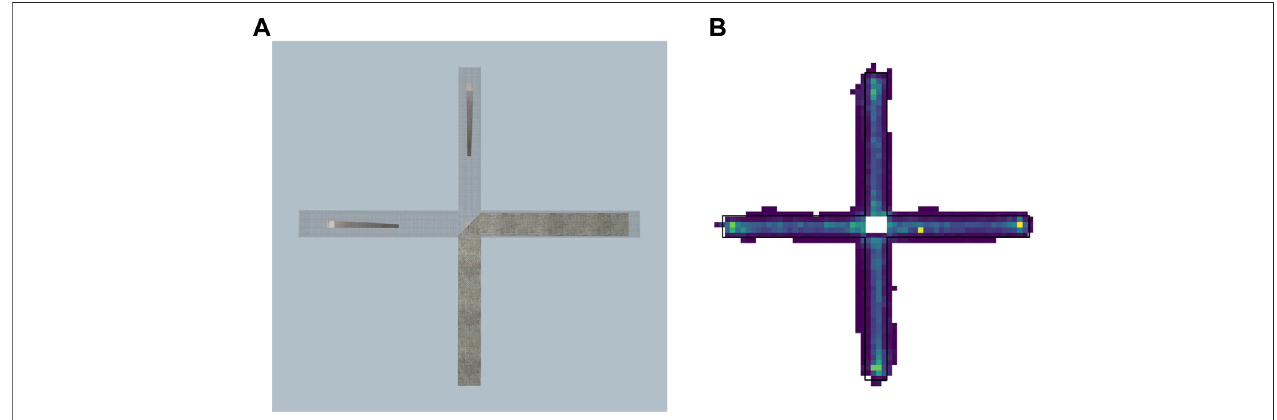
FIGURE 4 | (A) Top view screenshot of the virtual EPM depicting the different fl oor textures; vertical arms are open, horizontal arms are closed. (B) Heatmap of motion tracking data during the exploration phase ( N (cid:1) 61). Areas with lighter colors depict areas with greater activity.